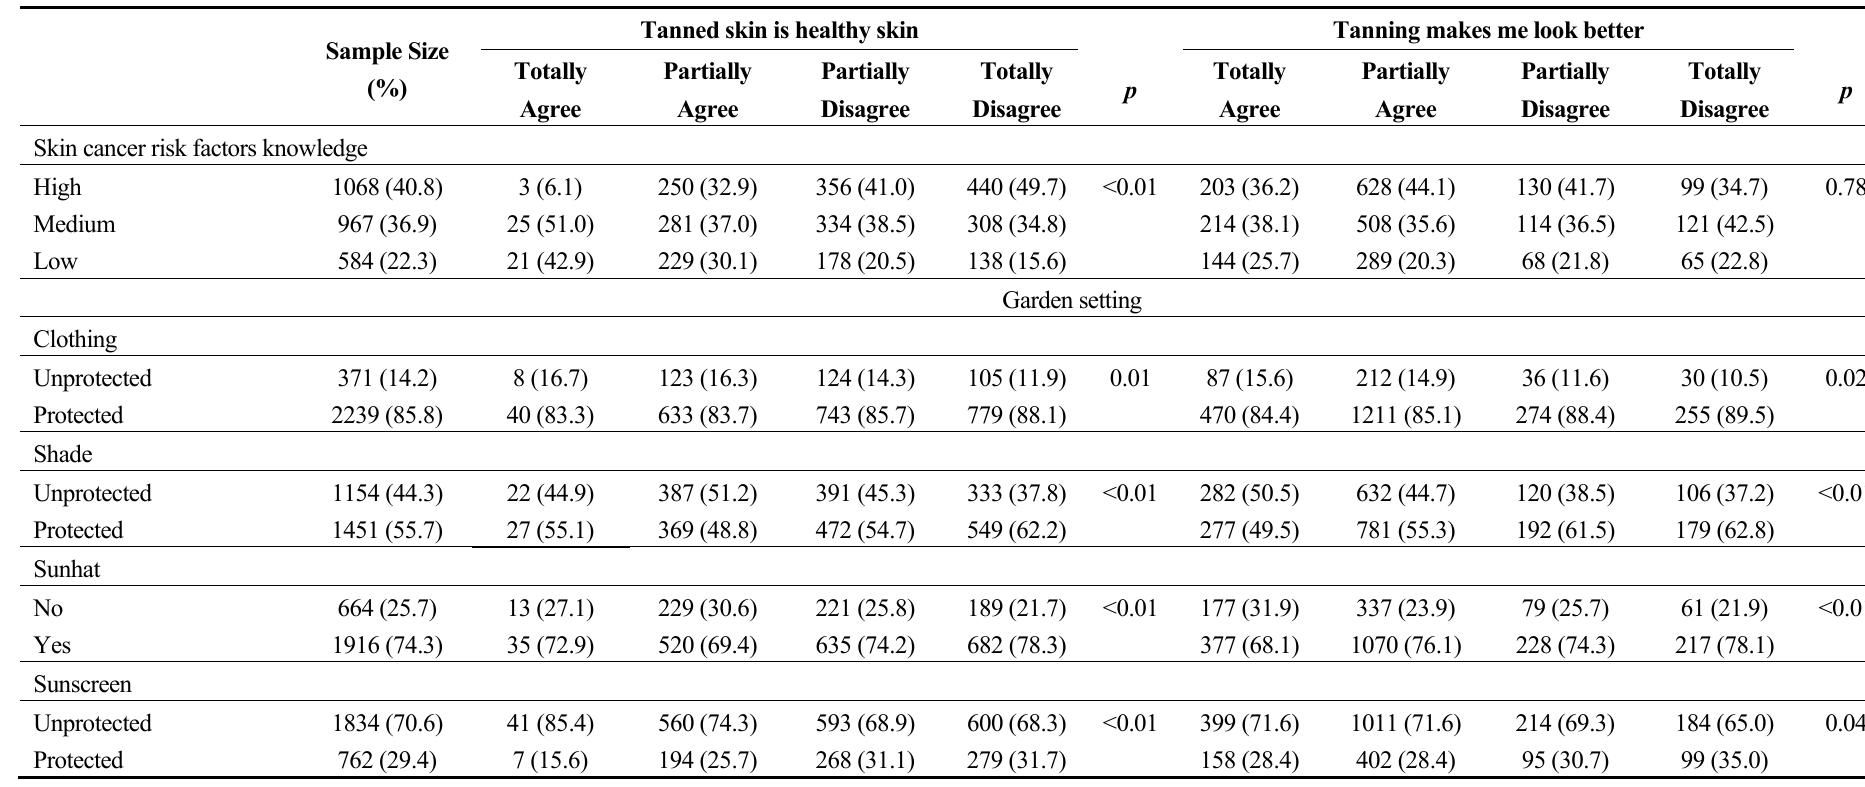
Table 1. The bivariate association of parental attitudes towards tanning with parental knowledge and sun protective measures for their children in the ErlKing study (n =